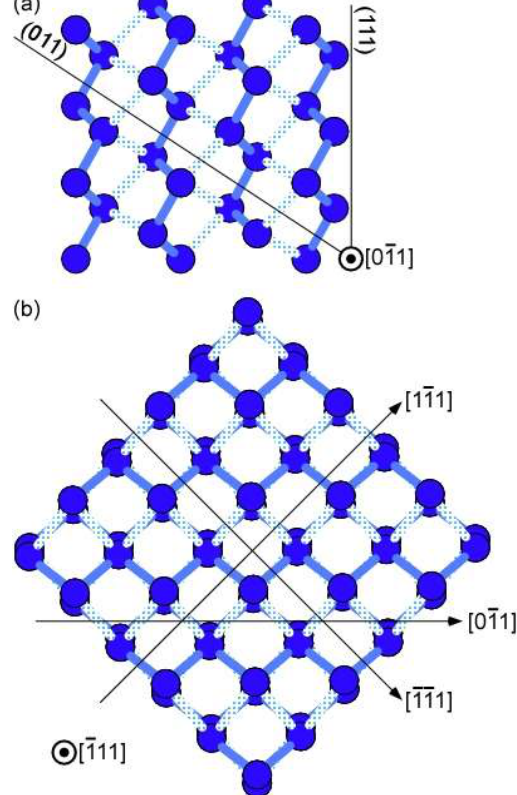
(cid:104) (cid:105) 011 (cid:104) (cid:105) 111